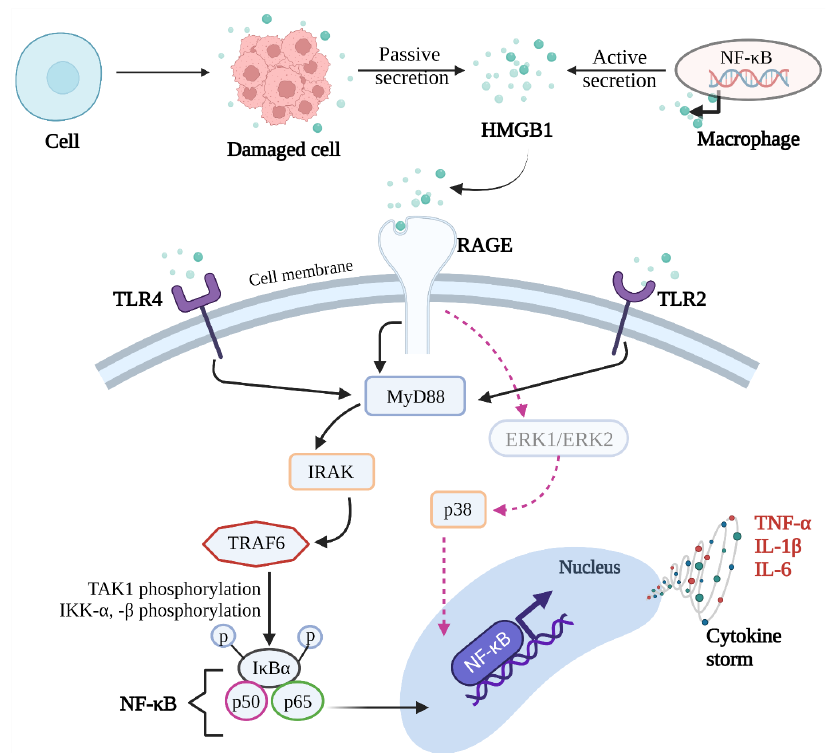
Figure 2. Active and passive secretion of HMGB1 and its interactions with RAGE, TLR2, and TLR4 to regulate the inflammatory cascade. Considering the role of HMGB1 and RAGE in various pathological conditions, it has been demonstrated that blocking their mutual interactions represents a promising strategy to regulate the inflammation associated with various disease conditions. In this article we reviewed several recent approaches reported in the literature to inhibit HMGB1 based on blocking the HMGB1/RAGE axis.